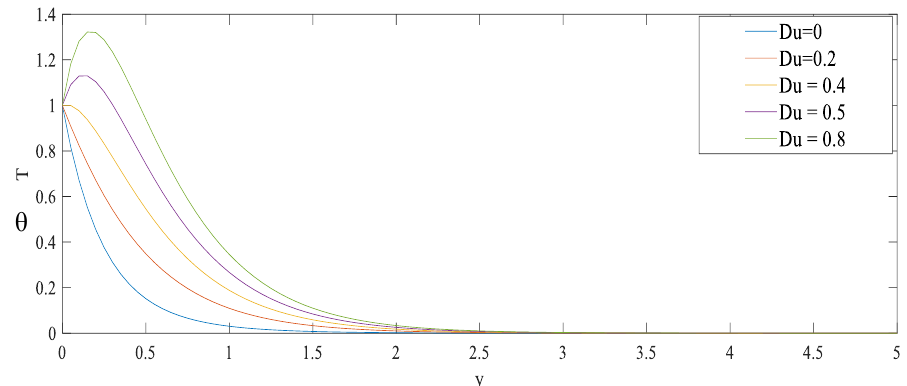
Figure 7. Temperature profile against displacement variable y for Nr=0.1, Pr=5, M=2, b=0.5, Sc=2, Kr=0.5, Q=0.2, Q1=0.3, e=0.001, eta(η) =0.2, n=0.1, Kp=0.3, Gr=5, n 1 =0.2, h=0.4, Gm=0.3 at t=0.5